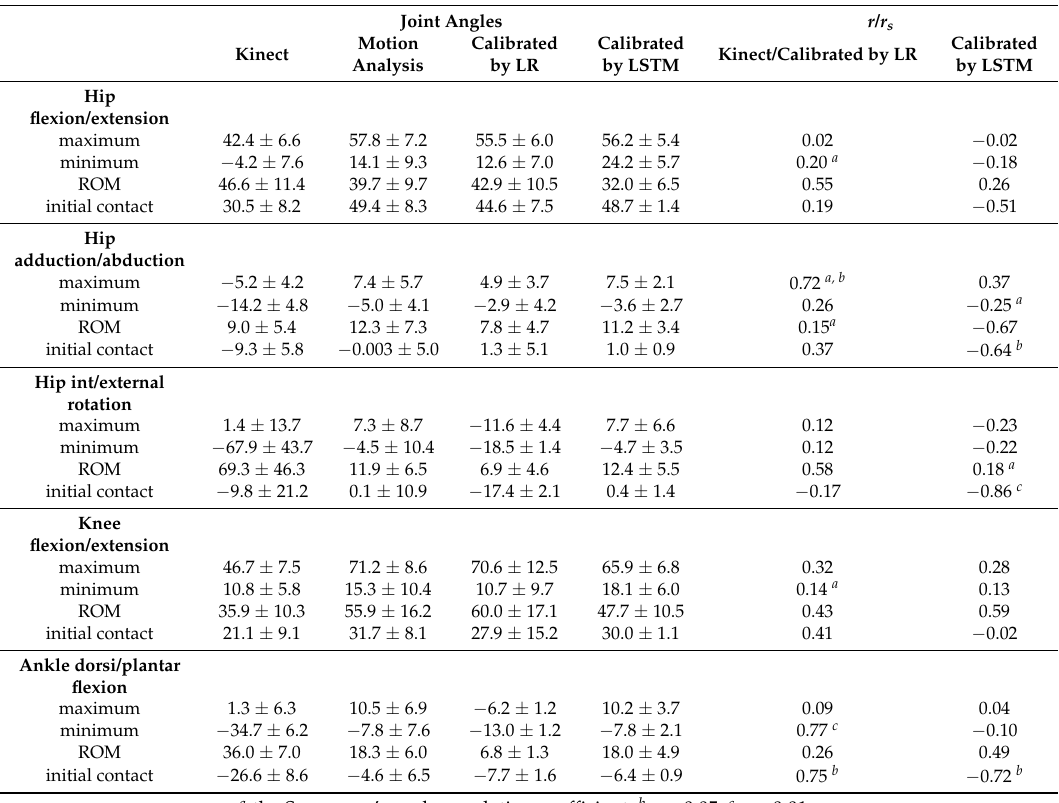
Table 4. Mean ( ± SD) values for each kinematic variables, Pearson ( r )/Spearman’s correlation coefficient ( r s ) between the kinematic variables, calculated by Kinect, Kinect calibrated by linear regression (LR) and LSTM, and Motion